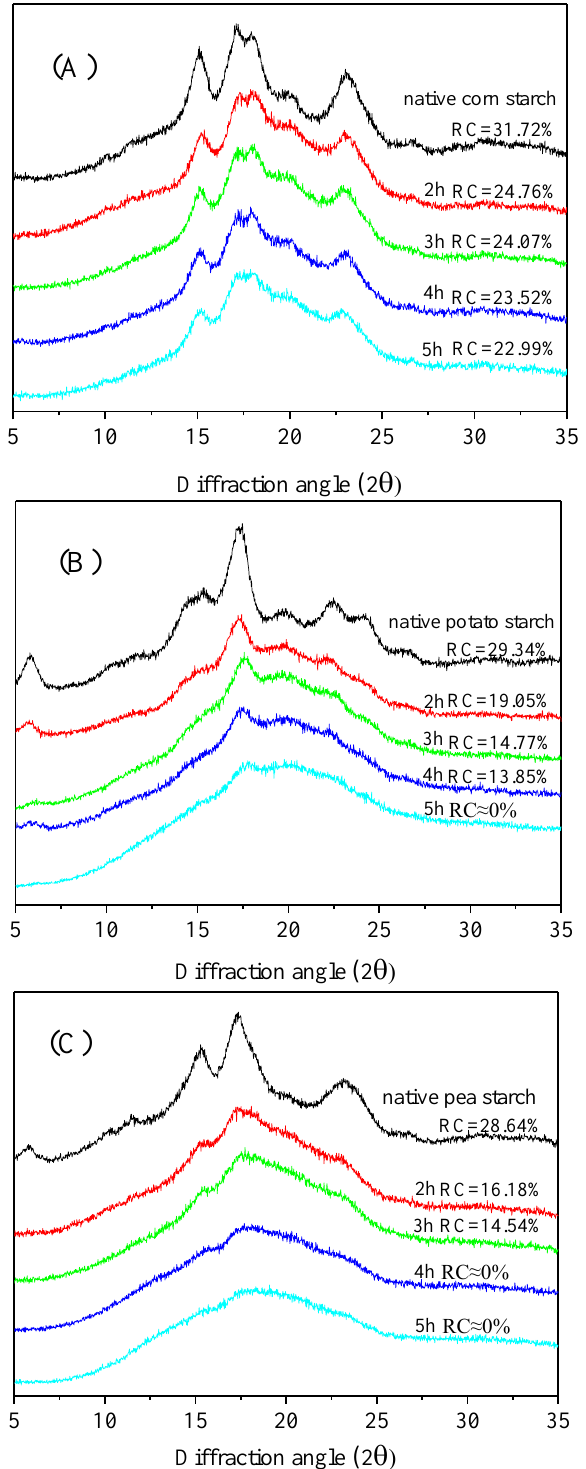
Figure 3. X-ray diffraction patterns of malate starch samples: ( A ) Corn starch, ( B ) Potato starch, ( C ) Pea starch.